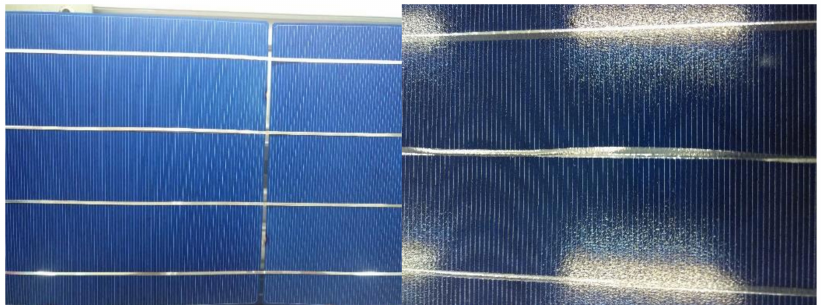
Figure 10. The normal reflective film position (left) of the conventional module and the reflective film drift (right) of the dual-glass module.